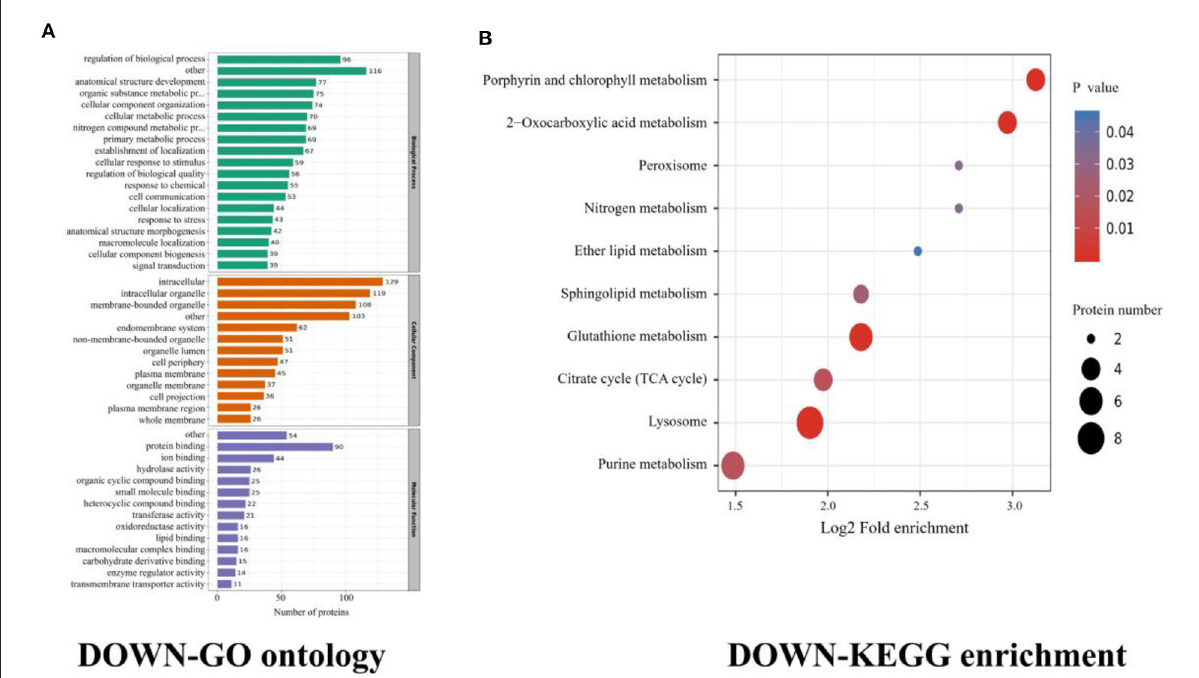
FIGURE2 Cysticercus (downregulated) proteins GO ontology and KEGG enrichment. (A) Gene ontology (GO) of cysticercus, dividing the annotated proteins into 3 categories: cellular component, molecular function, and biological process. The number of genes is expressed as the number of annotation proteins. (B) KEGG enrichment analysis of identified proteins in